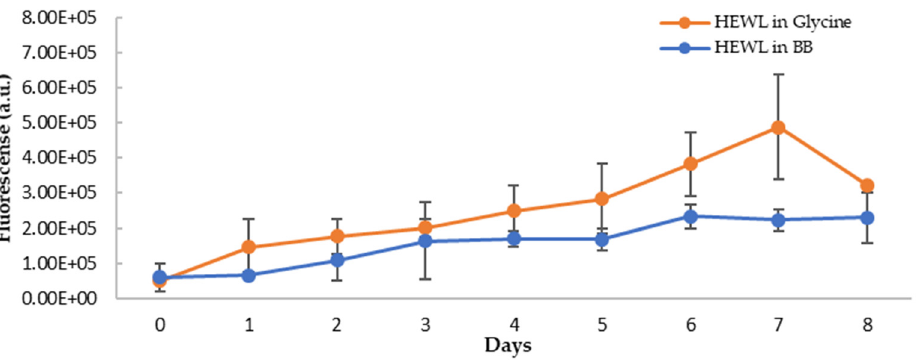
Figure 10. Fluorescence intensity of HEWL alone (orange) and blueberry-treated HEWL (blue) samples post-correction (emission at 623 nm, excitation at 530 nm). The error bars represent SD with three independent runs.